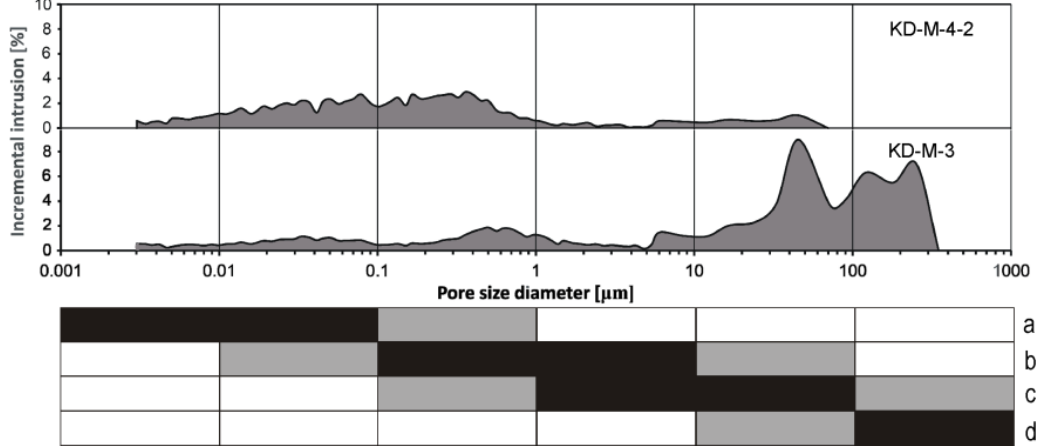
Figure 6. The pore size distribution of the cement based materials (samples KD-M-4-2 and KD-M-3)—for position of the samples, see Figure 1—with regard to certain processes: a—vapor absorption and capillary condensation; b—salt and ice crystallization; c—capillary imbibition; d—mechanical strength in the material pore space. Intensities and ranges of the processes after Benavente [39].